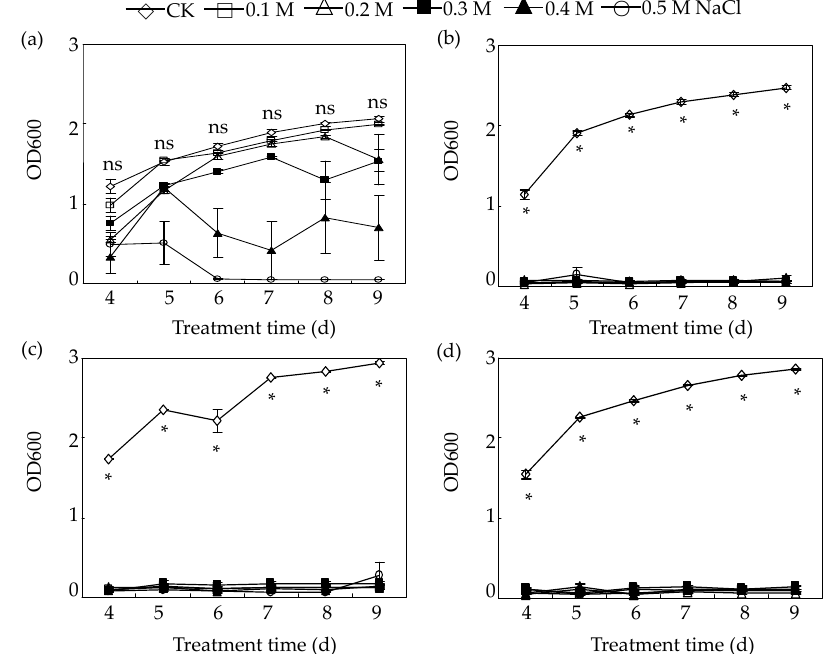
Figure 2. Rhizobial growth affected by NaCl treatment. ( a ) RJS9-2; ( b ) BS1-1; ( c ) PN13-3; ( d ) LZ3-2. The four tested Bradyrhizobium strains were separately inoculated into liquid medium containing 0.0017 (CK), 0.1, 0.2, 0.3, 0.4, or 0.5 M NaCl and incubated at 28 °C for 4 to 9 days. The optical density (OD) of the cultures was recorded every 24 h at 600 nm. Each bar represents the mean of four biological replicates with standard error. An individual flask was considered one biological replicate. Asterisks (*) indicate significant differences between CK and other NaCl concentrations at a given time at p < 0.05 (Student’s t -test). ns indicates no significant difference between CK and other NaCl concentrations at a given time at p < 0.05 (Student’s t -test).